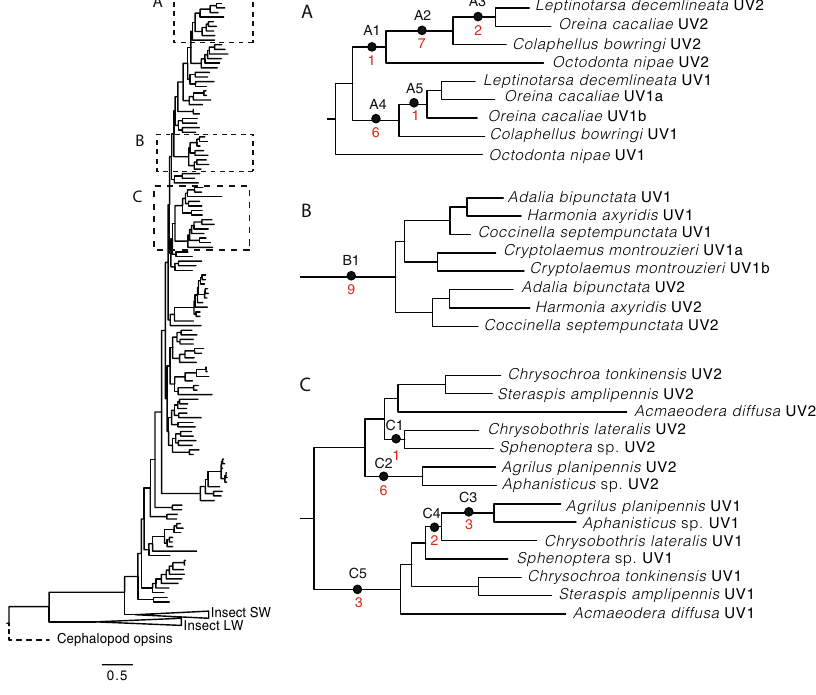
Figure 3. Signals of selection within beetle UV duplication clades. Branches (closed circles) and numbers of sites (red values) under positive selection in the three major coleopteran UV opsin clades. Positions of these clades, ( A ) (Chrysomelidae), ( B ) (Coccinellidae) and ( C ) (Buprestidae), on the full opsin DNA phylogeny are indicated (dashed boxes). For further positive selection statistics and amino acid sites see Tables S4 and S5.